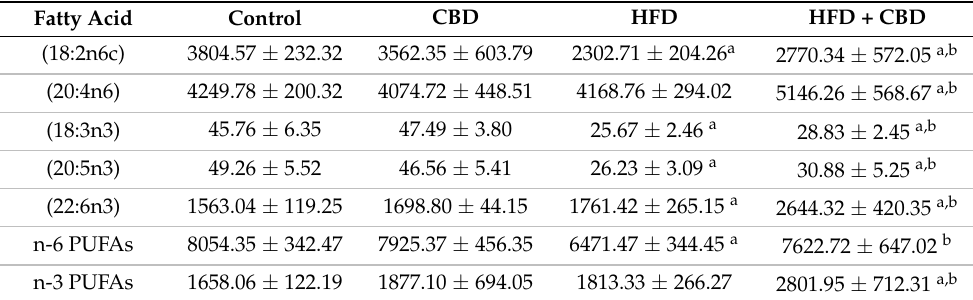
Table 7. Polyunsaturated fatty acids (PUFA) content in the PL fraction (nmol/g of wet tissue) in the white gastrocnemius muscle in the control (standard diet) and high-fat diet (HFD) groups after two-week cannabidiol (CBD) treatment.